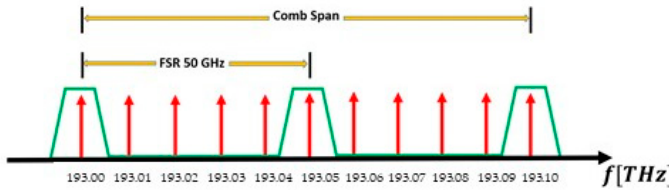
Figure 4. Illustration of the filter designed when the Comb Span is greater than the FSR of the filter. We look for just one comb line, and more than one is selected. This is an example of a comb with 10 GHz frequency spacing.